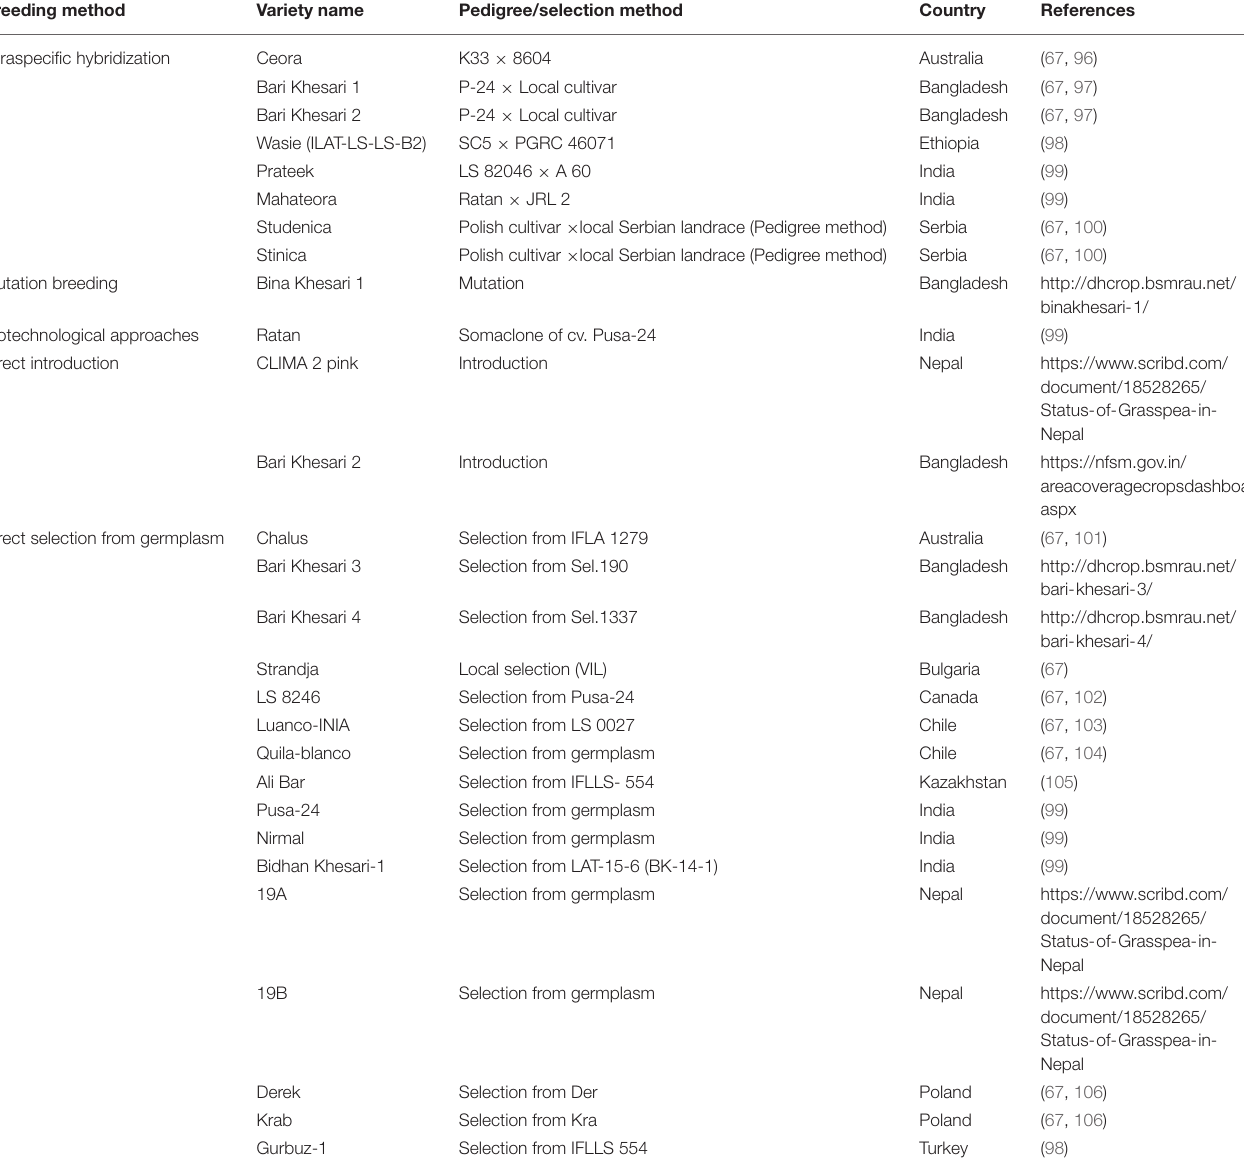
TABLE 4 | Low- β -ODAP grasspea cultivars released in Australia, South Asia, Central Asian, Mediterranean, East African and Latin American